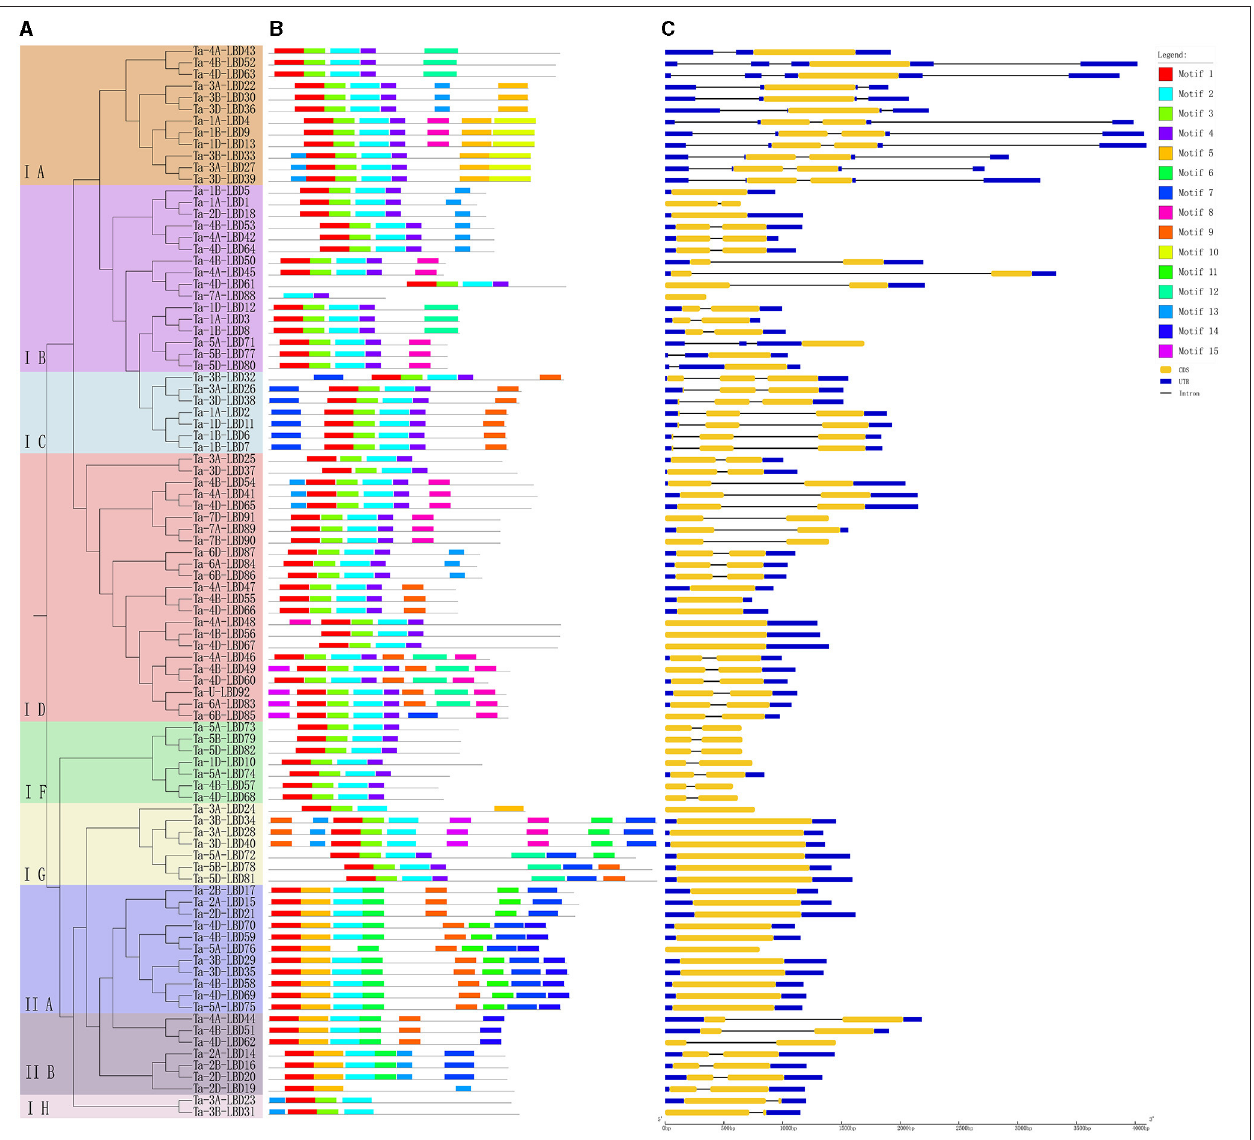
FIGURE 3 | Phylogenetic relationship (A) , conserved motifs (B) , and gene structure (C) of LBD genes in wheat. The conserved motifs analysis of the LBDs based on their phylogenetic relationship were identified using MEME software. The different colors represent the 15 identified motifs. The yellow and blue rectangles represent the coding sequences (CDSs) and untranslated regions (UTRs), respectively, and the black lines represent introns. The lengths of the CDSs, UTRs, and introns for each LBD gene are shown proportionally. LBD, lateral organ boundaries